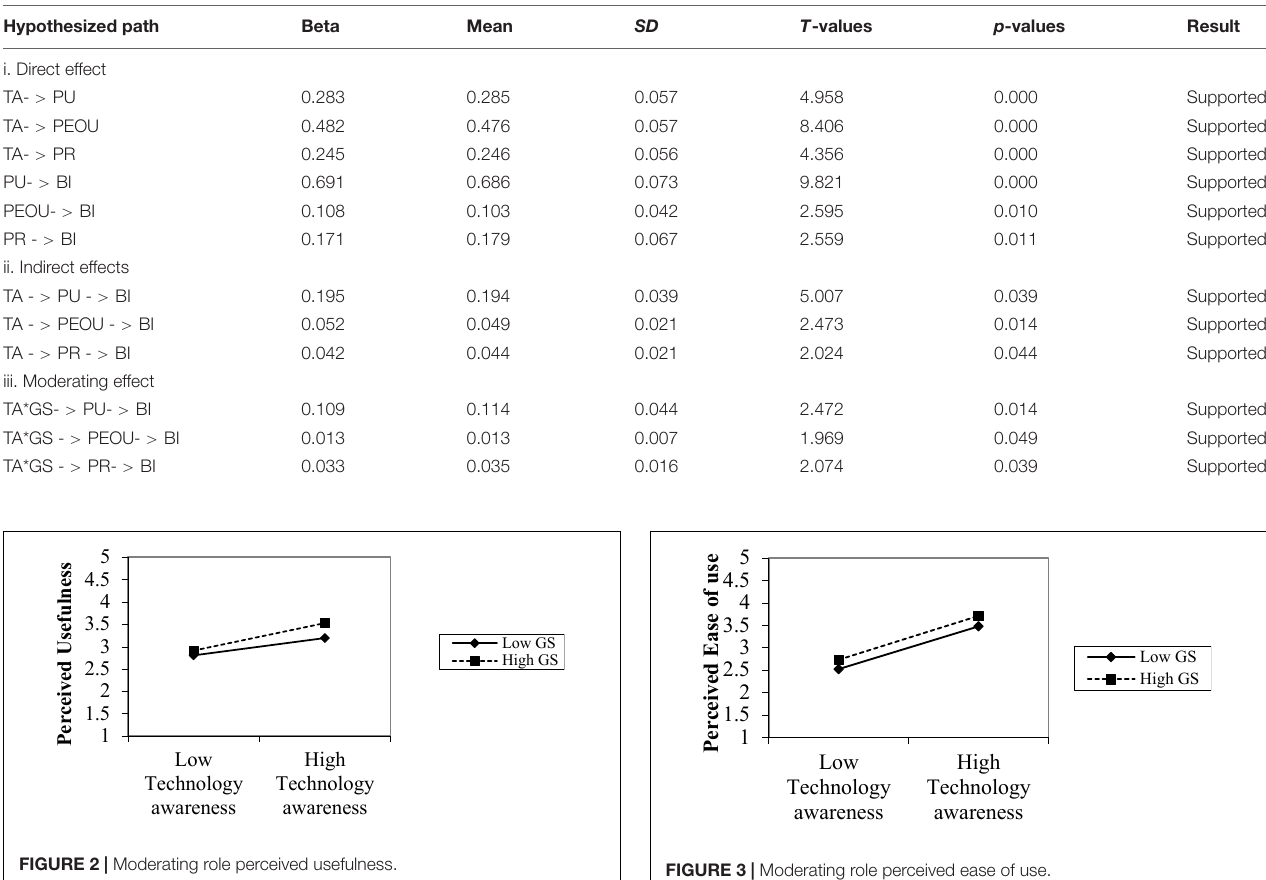
TABLE 4 | Results for structural equation model.